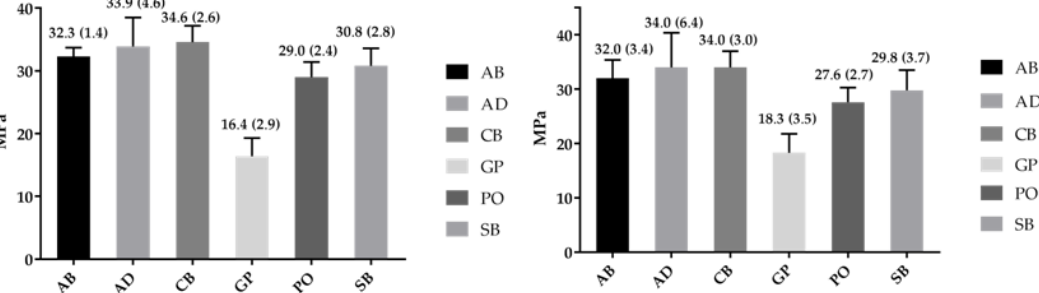
Figure 4. Mean values and standard deviation for shear bond strength to polished 3Y-TZP before ( left ) and after alumina-blasting ( right ).